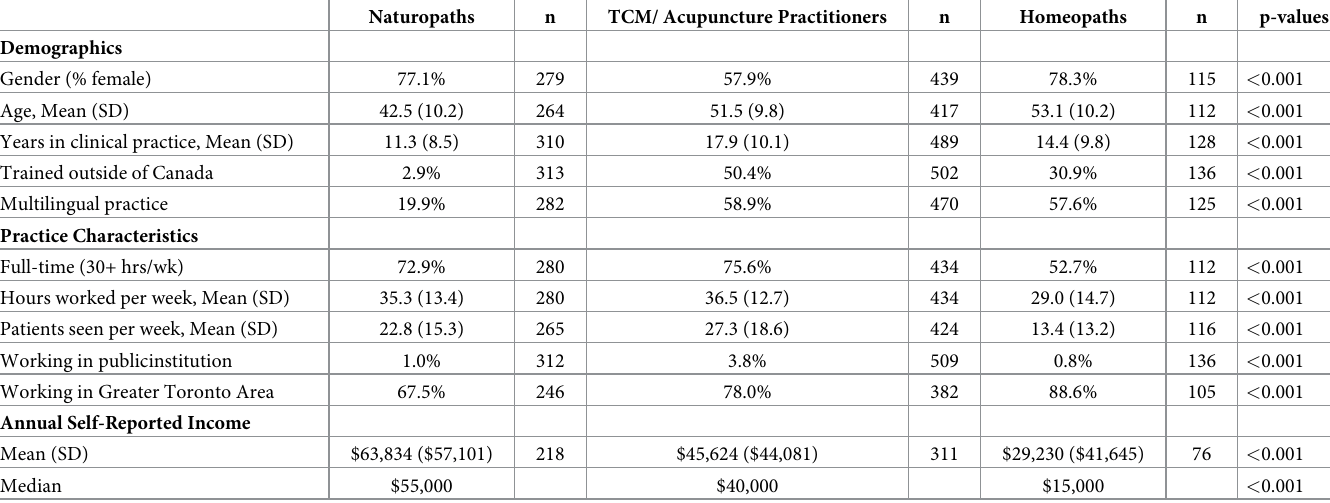
Table 2. Demographics, practice characteristics and annual self-reported